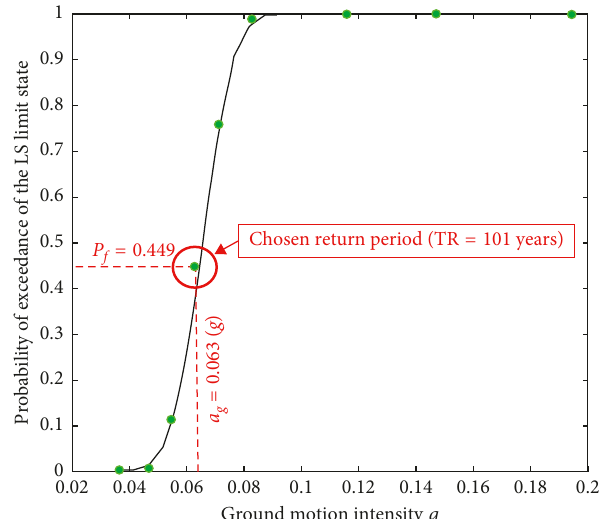
F IGURE 9: Fitted fragility curve for exceeding the LS limit state for the example building (no. 39).